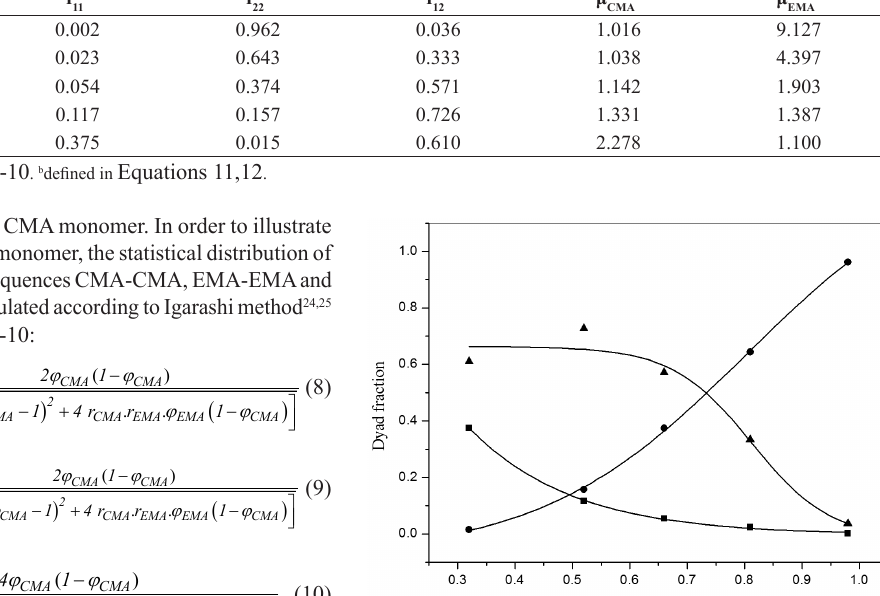
Table 3. Structural data for the statistical copolymers.